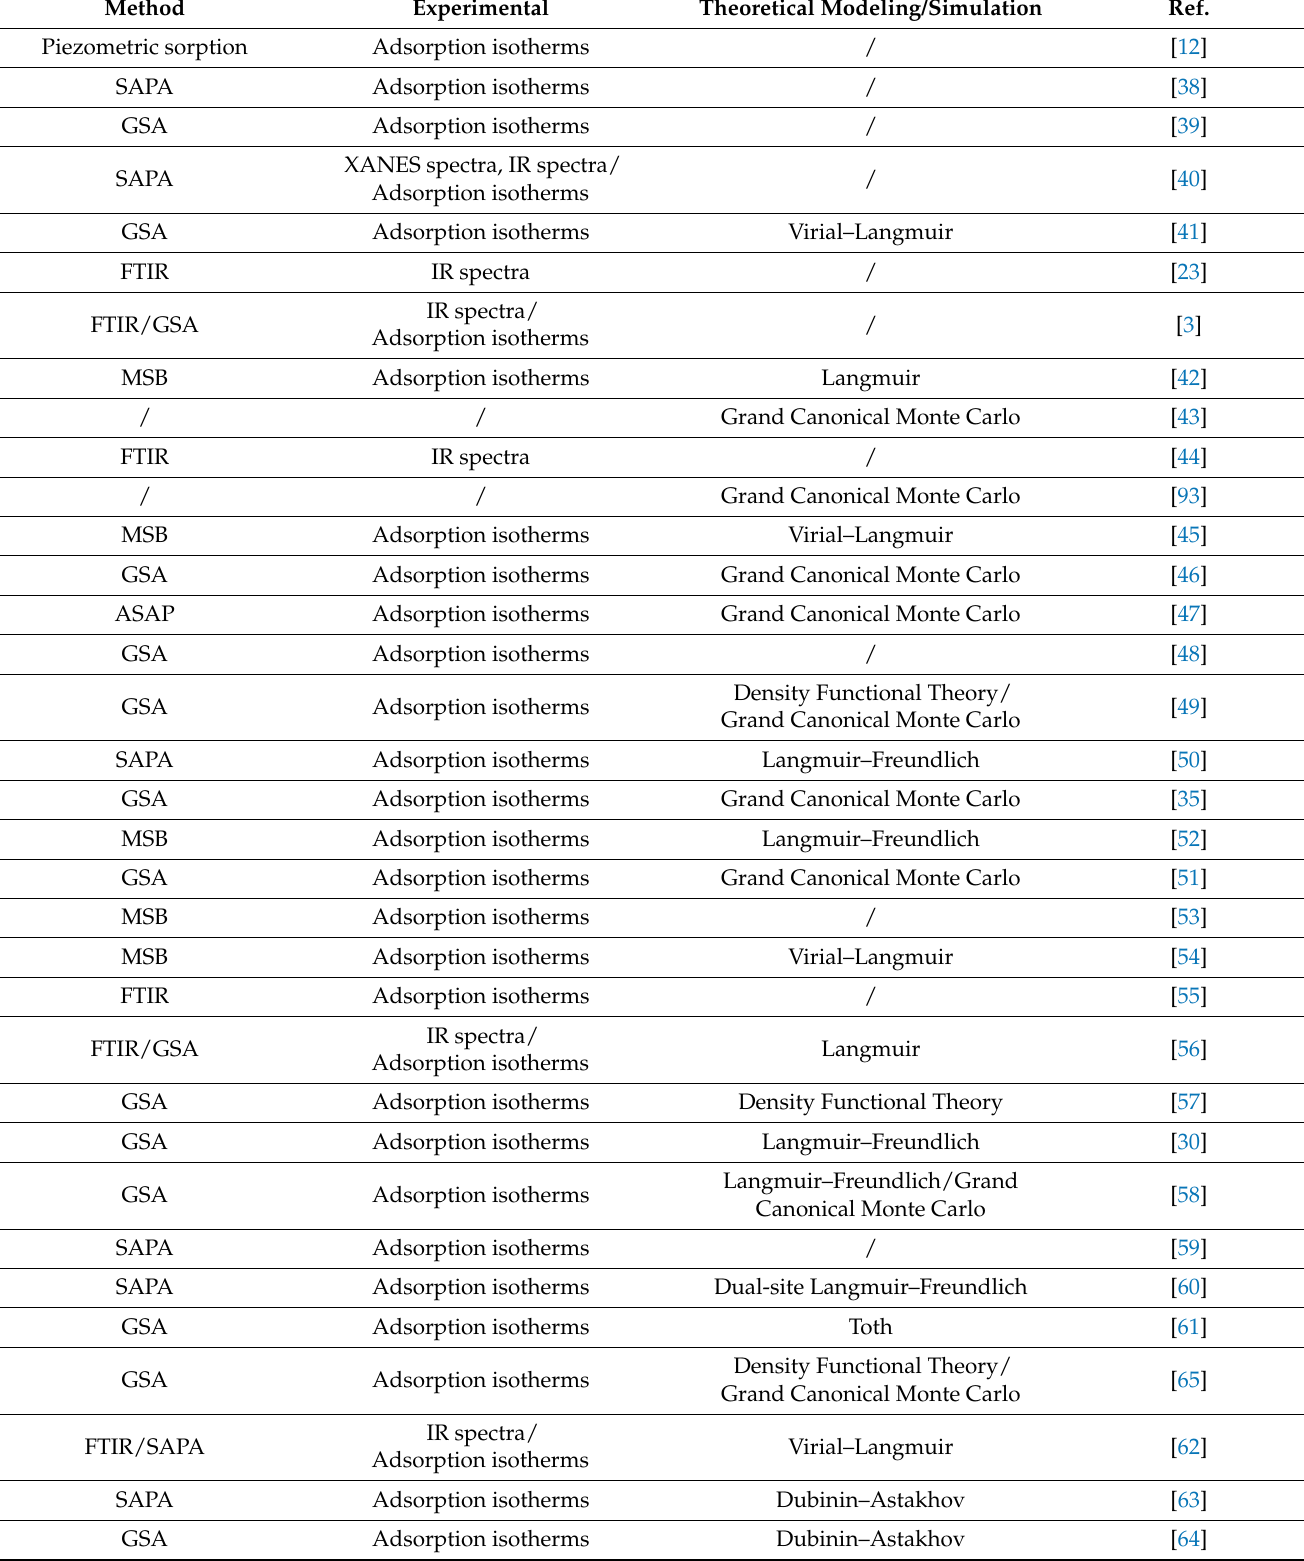
Table 2. Combined experimental and theoretical approaches used to characterize the interaction between the adsorbent and adsorbate retrieved from the